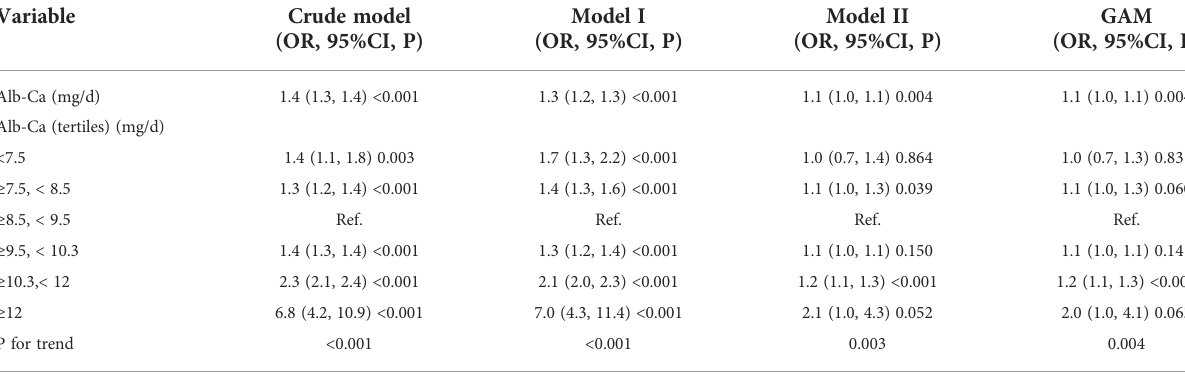
TABLE 3 Relationship between albumin-corrected calcium (mg/dl) and 30-day in-hospital mortality in different models. Variable